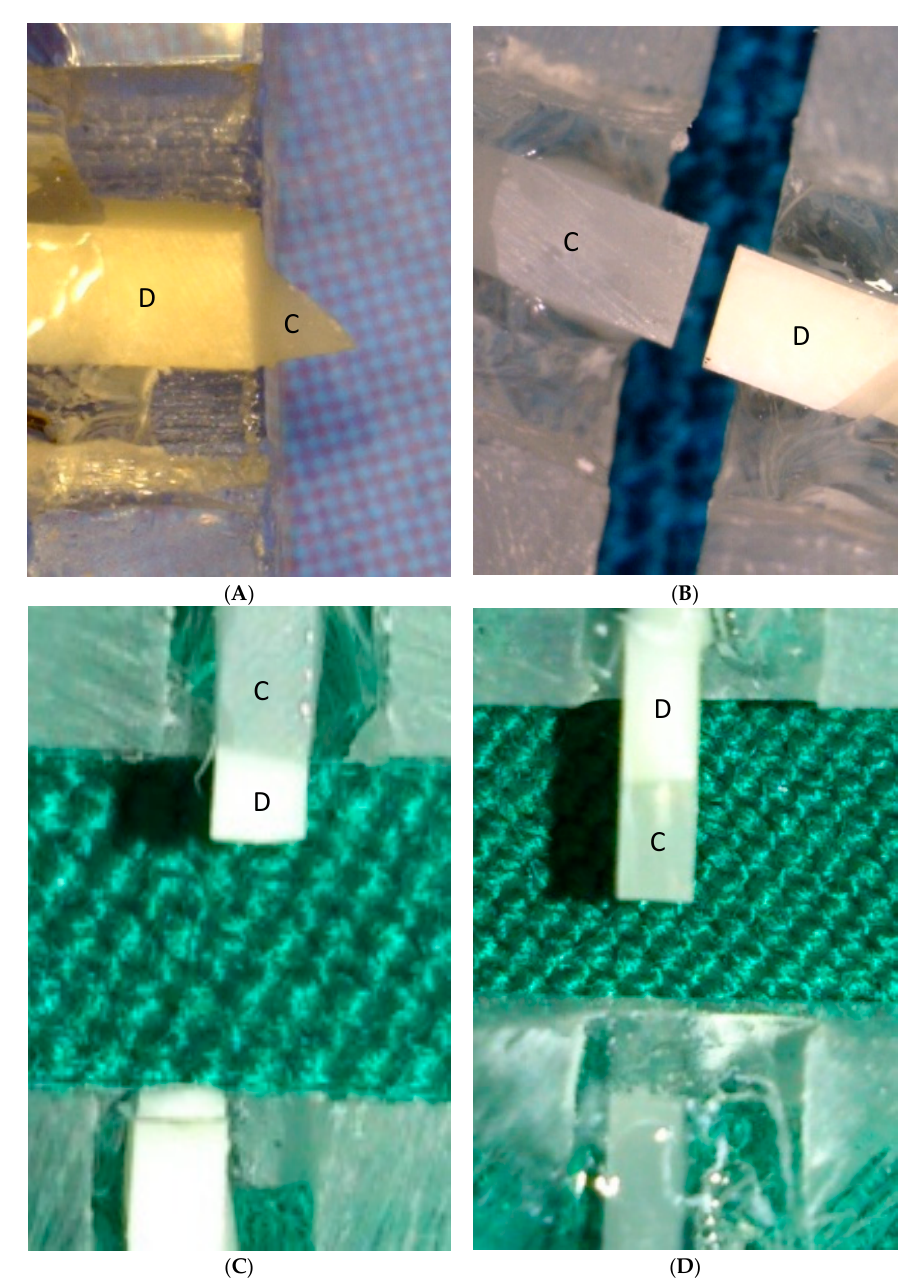
Figure 1. Modes of failure of the experimental groups. ( A ) Mixed failure; ( B ) adhesive failure; ( C ) cohesive failure of dentin; ( D ) cohesive failure of composite. C: Composite; D: Dentin.